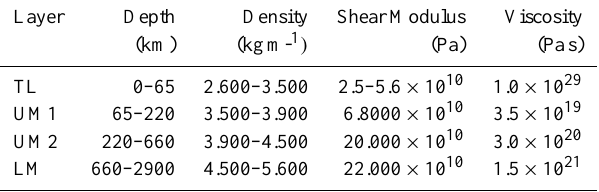
Table 2. Rheological parameters for layered Earth model. TL is top layer including the crust, UM1 is upper mantle Part 1, UM2 is upper mantle Part 2 and LM is lower